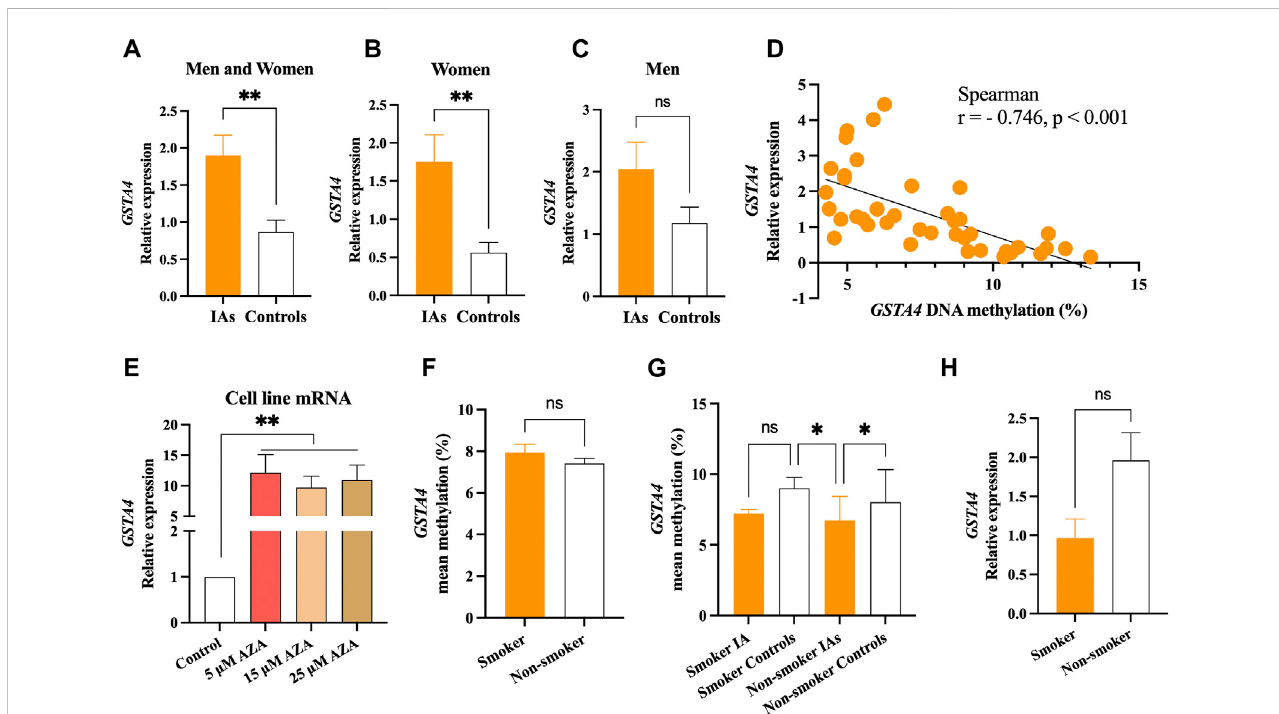
FIGURE 3 Signi fi cant association between GSTA4 mRNA expression and DNA methylation. (A) mRNA expression levels in the IA group were higher than that in controls. (B) mRNAexpressionlevelsinwomenIAswerehigherthanthatinwomencontrols. (C) Nostatisticalsigni fi cancewasobservedbetweenmenIAsand men controls. (D) GSTA4 mRNA expression was correlated with its DNA methylation levels in all participants. (E) DNA hypomethylation induced by AZA increased the mRNA expression of the GSTA4 gene in HBVSMCs. (F,G) GSTA4 methylation levels in between smoker and non-smoker group. (H) GSTA4 mRNA expression between smoker and non-smoker groups.